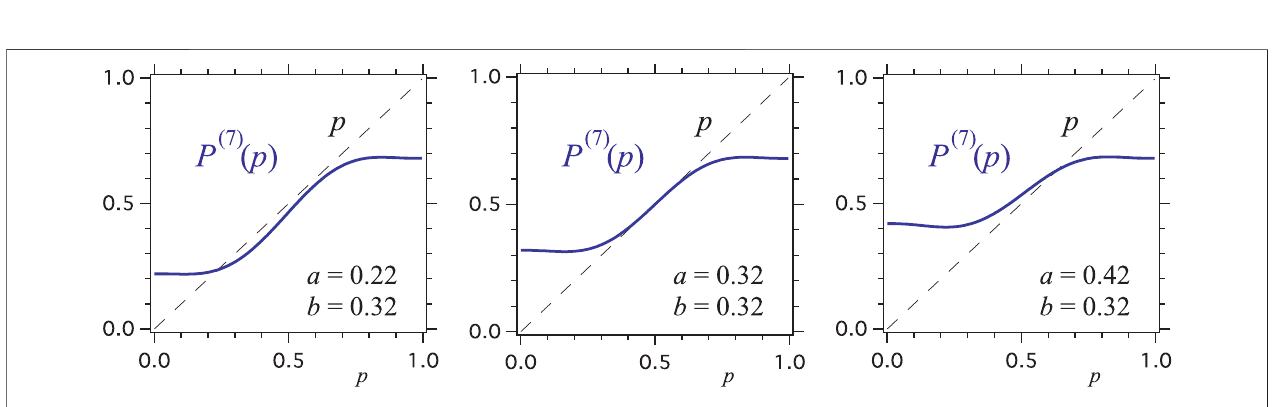
FIGURE 5 | Examples of the evolution function P r a , b , c , k ( p ) around critical value a (cid:2) a c for b (cid:2) c (cid:2) 0. The group size is chosen to be r (cid:2) 7.